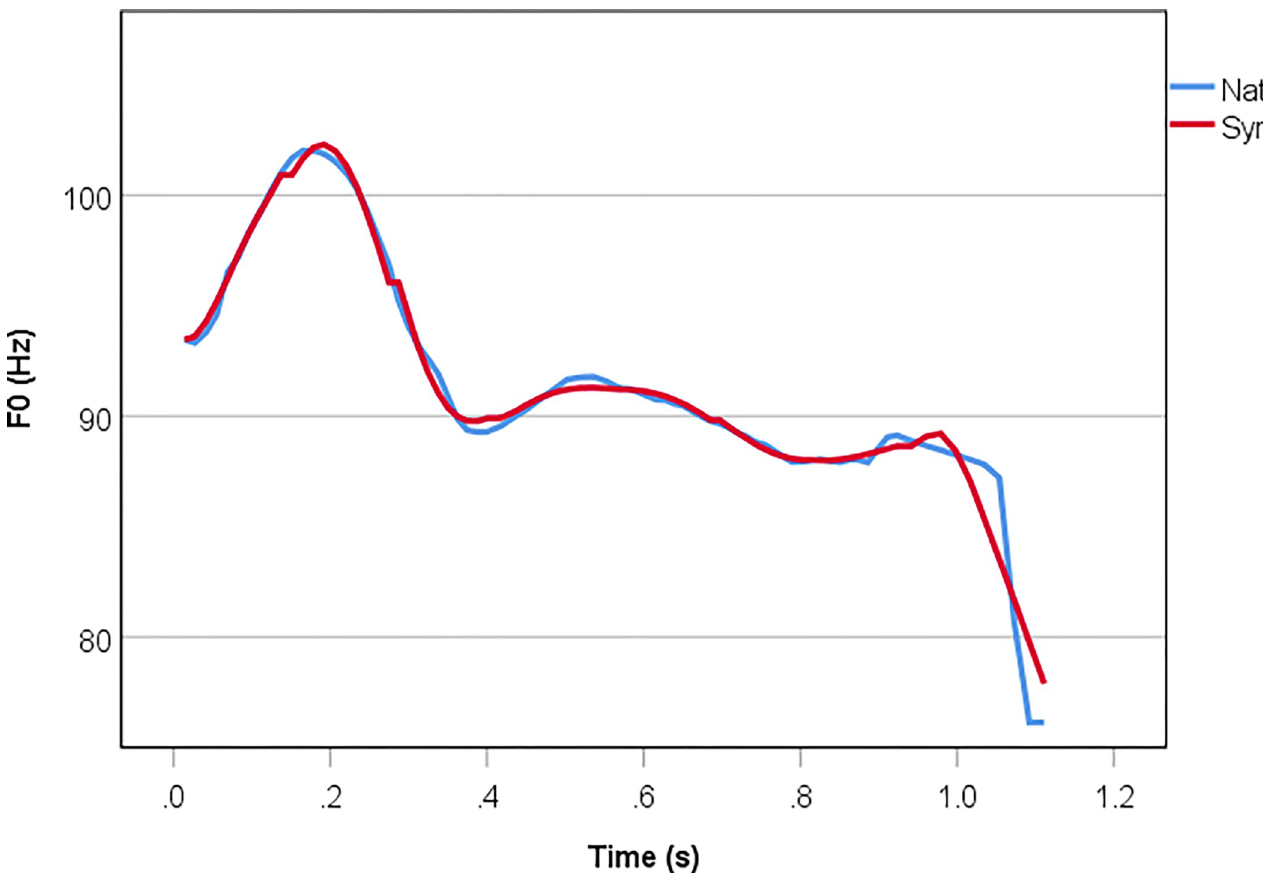
Fig 3. F0 contour of a natural vs. corresponding synthesised utterance ( me’i-ga mo’mo-o mi’ta ) in neutral focus. X-axis shows actual time.